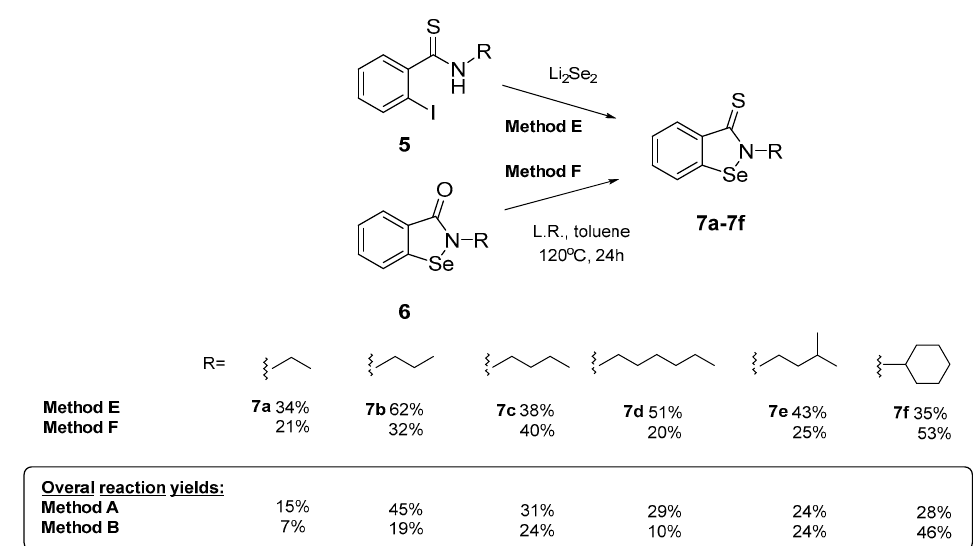
Table 2. Results of the antioxidant activity